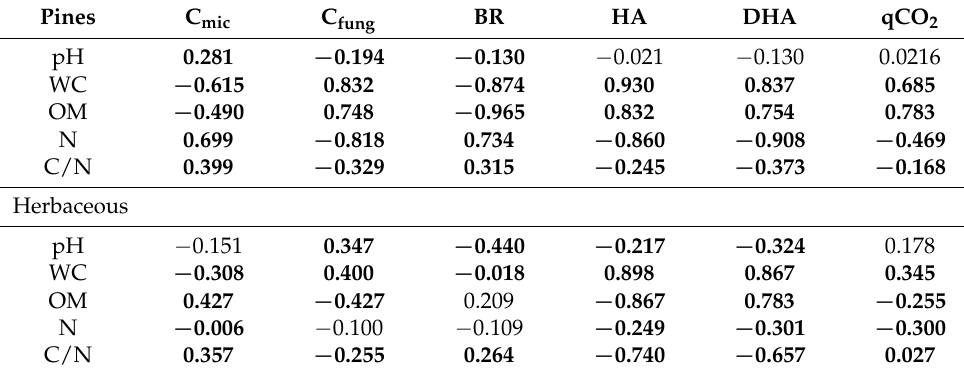
Table 2. Coefficient of Spearman’s correlation performed between physico-chemical and biological parameters of the soils sampled before the